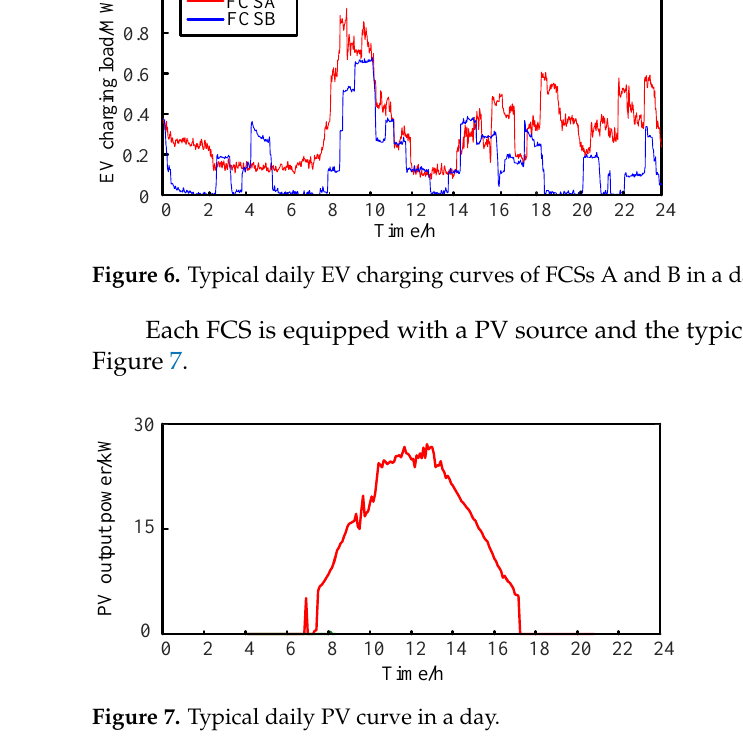
Figure 7. Typical daily PV curve in a day.